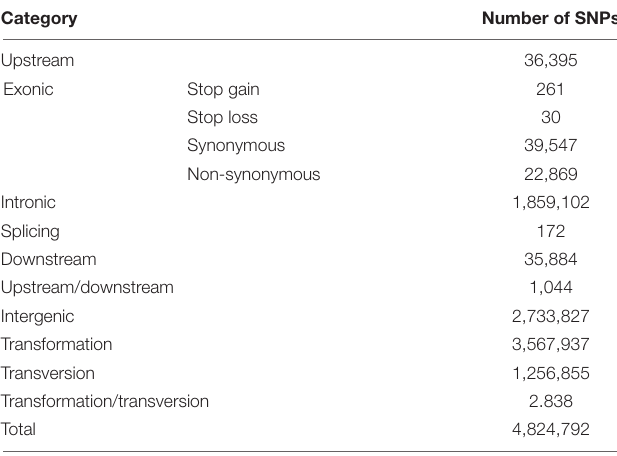
TABLE 1 | Characteristics and numbers of identified SNPs for 120 individuals of four breeds fine-wool sheep (sequencing depth 5 × ).